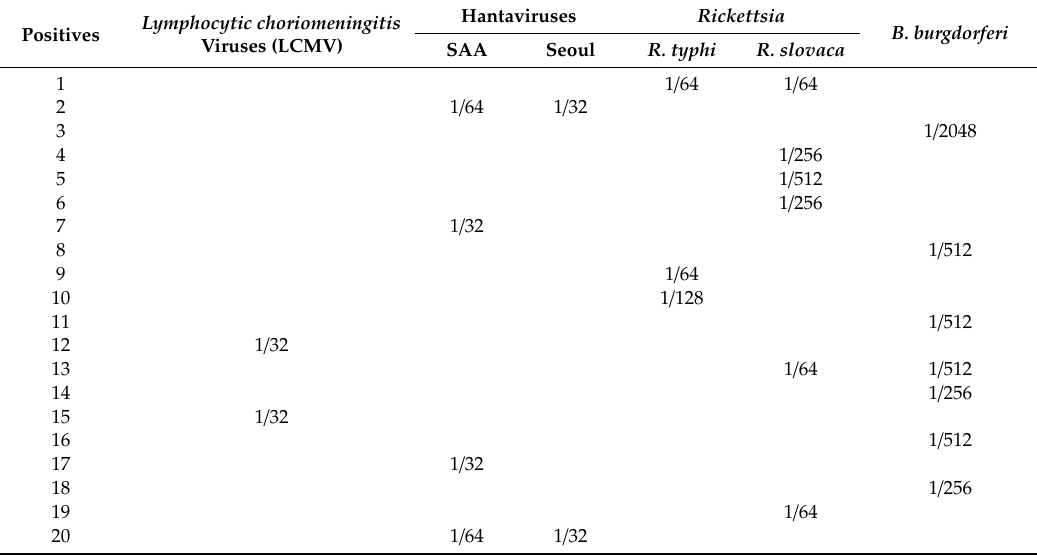
Table 2. Serum titers (IgG) for the studied